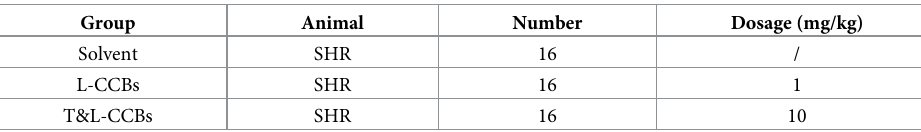
Table 1. Groups of experimental animals and